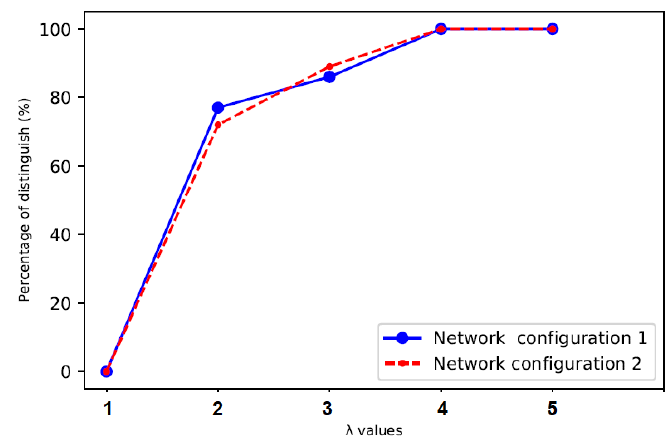
Figure 3. Accuracy of distinguishing covert traffic from legitimate